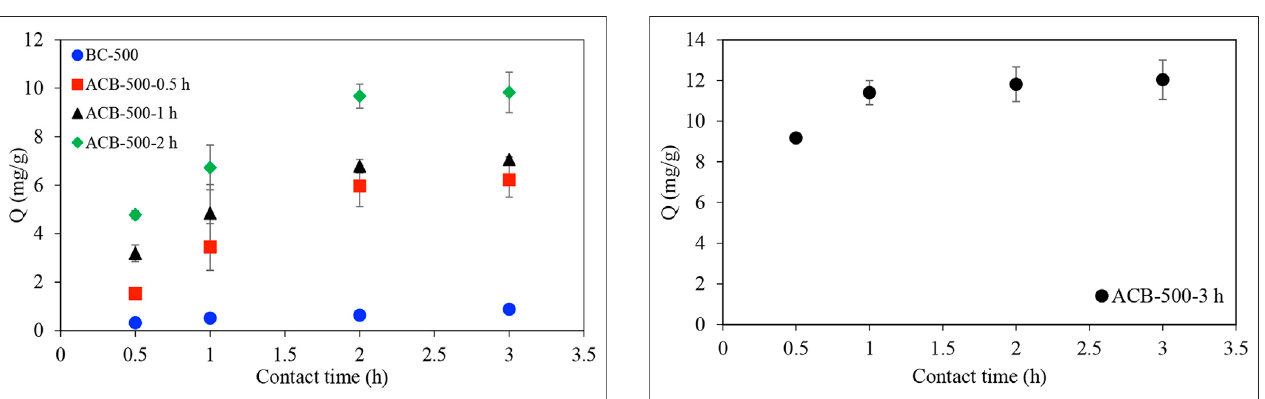
FIGURE 12 | Ibuprofen adsorption pro fi le using ACB-500-3 h sample in an ibuprofen solution with the concentration of 120 mg L − 1 . 30 ml samples with 120 mg/L of ibuprofen concentration to which 100 mg of activated bio- char was added.